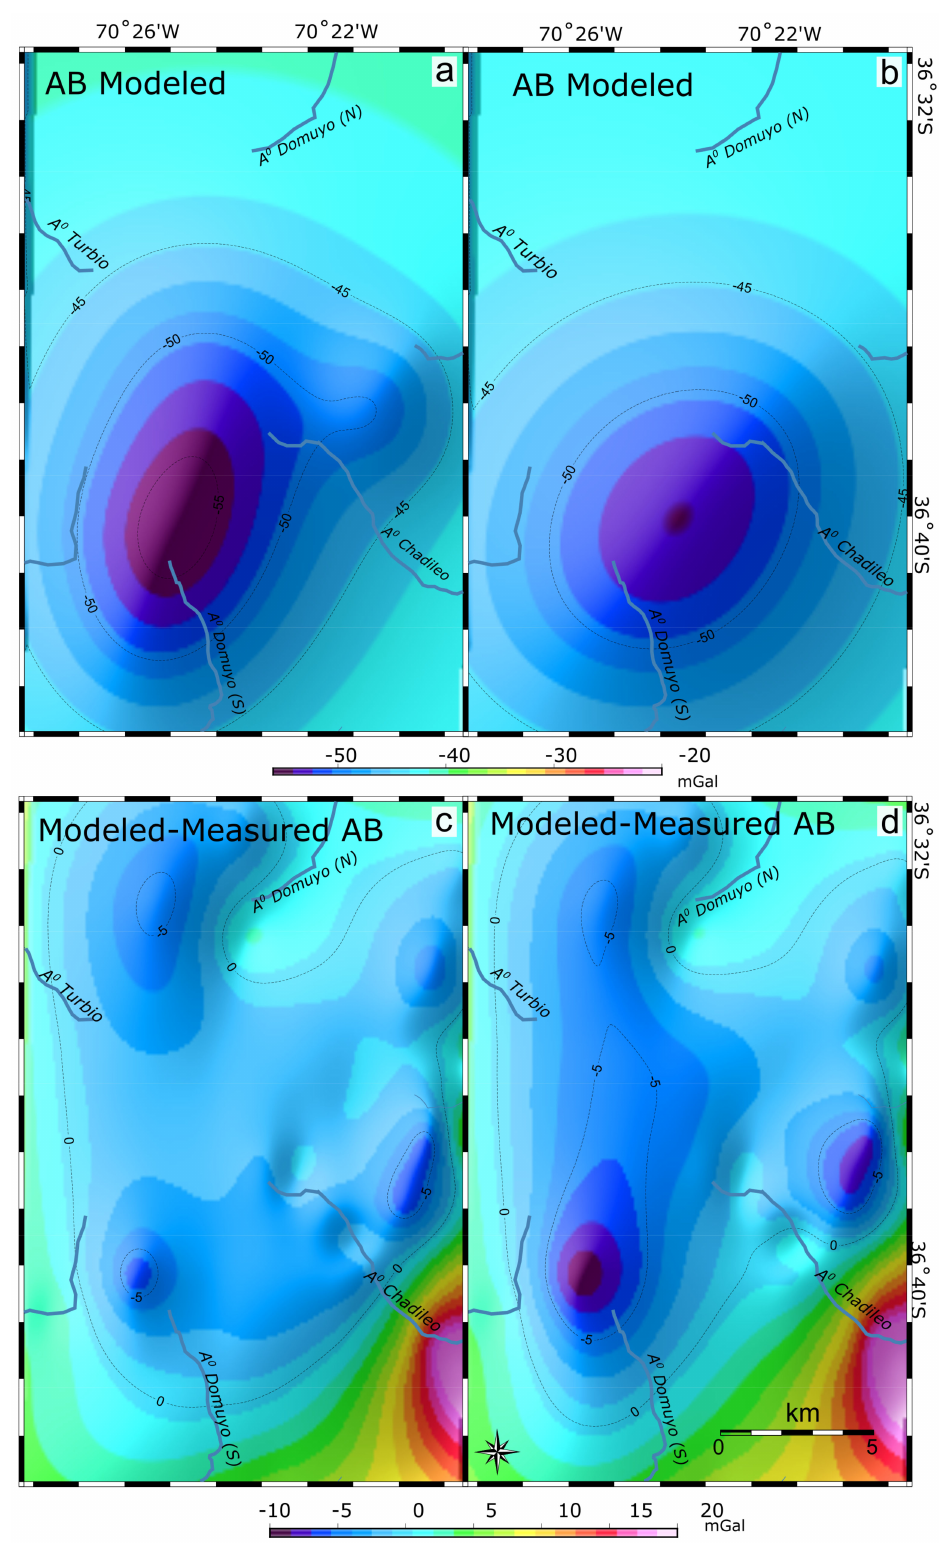
Figure 10. 3D density-modeled Bouguer anomalies from the two tested geometries: ( a ) the modeled body located at 4 km depth. ( b ) The geometry adjusted to the InSAR modeling that is located at 6 km depth. ( c ) The corresponding residuals from ( a ). ( d ) The corresponding residuals from ( b ) that present higher values at the center of the